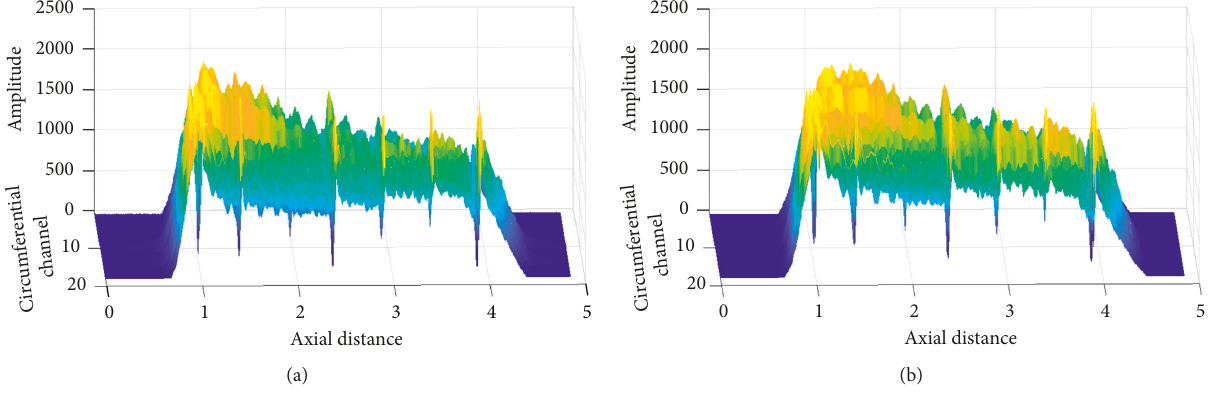
Figure 6: The original MFL data. (a) The first board. (b) The second